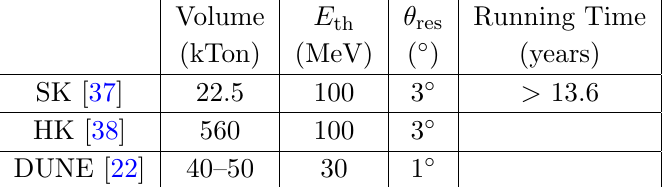
Table 1 . List of experiments (SK, HK, and DUNE) studied in this paper with volume, threshold energy, angular resolution, and running time. In principle, the threshold energy at SK/HK could be lowered below 100 MeV at the cost of having worse energy and angular resolution. However, in our study we use 100 MeV to reduce backgrounds from solar neutrinos and muon decays [16]. We consider two di(cid:11)erent sizes for DUNE: 10 kTon (DUNE 10) and 40 kTon (DUNE 40), since the staged implementation of the far detector as four 10 kTon modules is planned